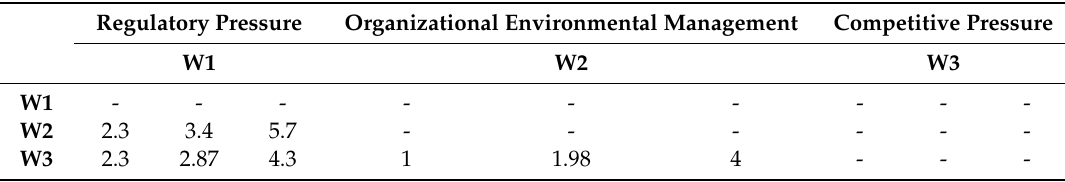
Table 10. Paired comparison matrix of KPIs in the FMCG industry green supply chain, based on integration of experts in environmental section.